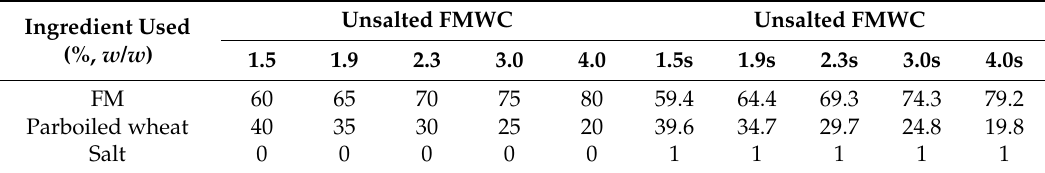
Table 1. Ingredients used in formulation of salted and unsalted dehydrated fermented milk–wheat composites (FMWC) 1,2